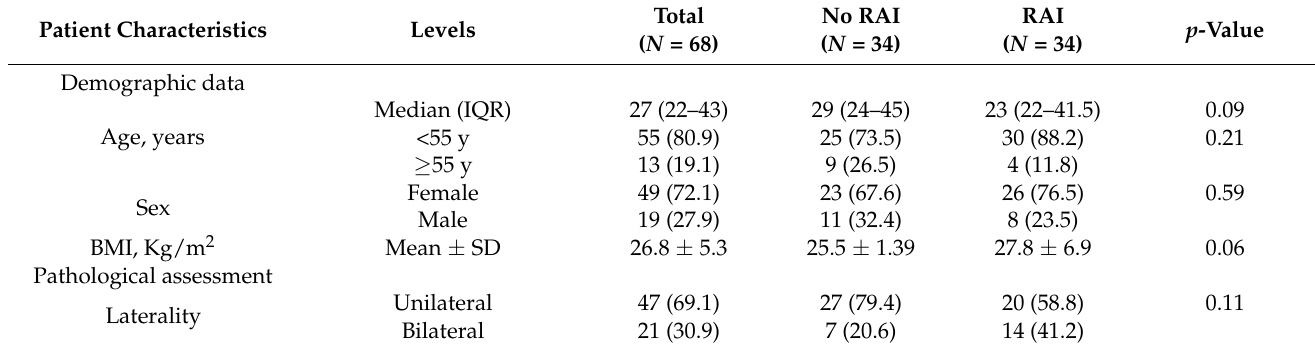
Table 1. Baseline characteristics of propensity score-matched cohorts ( N =